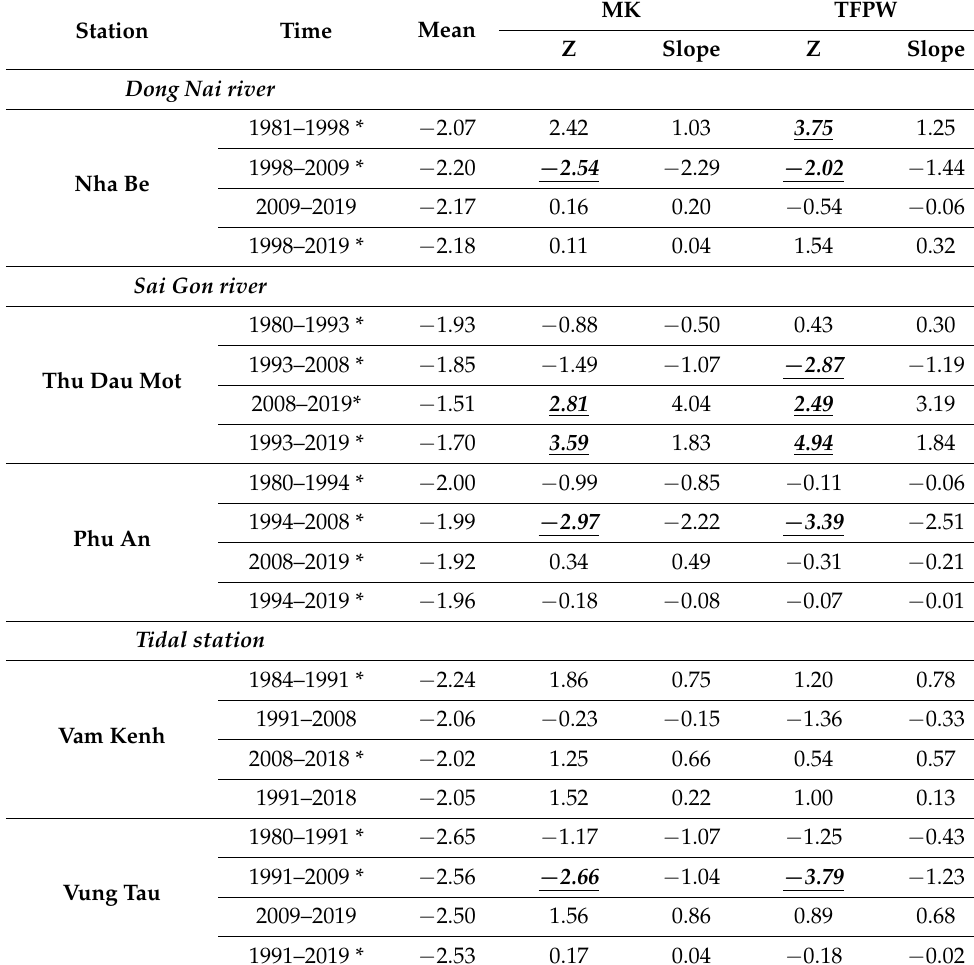
Table 9. Periodic water level trend at H p1%